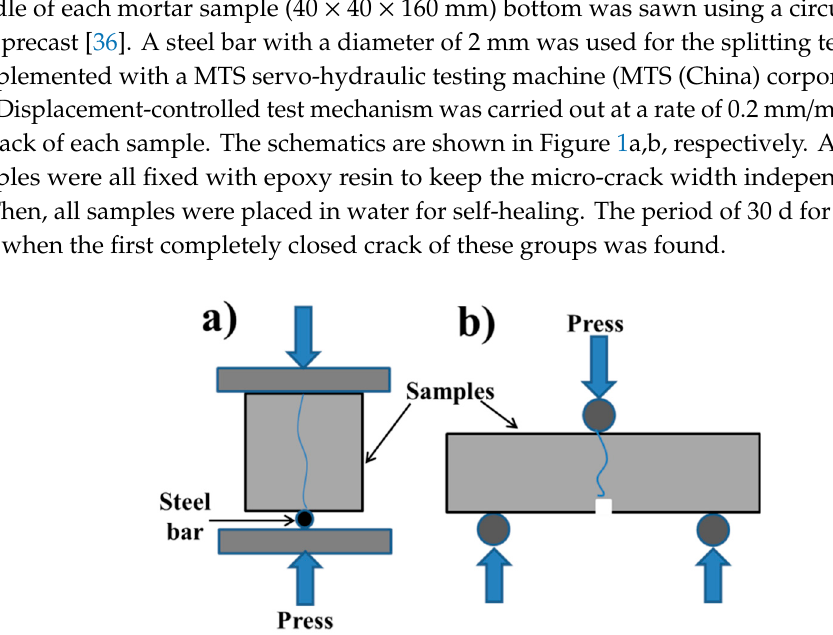
Figure 1. The schematic of prefabricating micro-cracks. ( a : the schematic of the splitting test, b : the schematic of the three-point bending